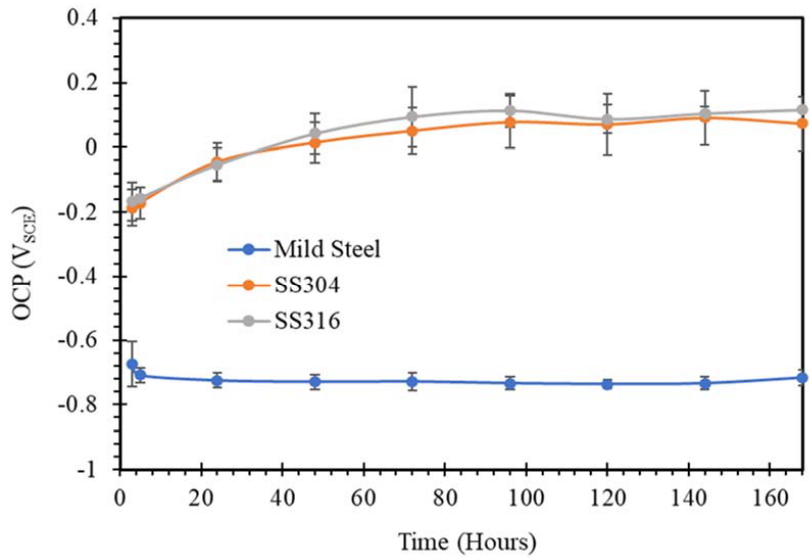
Figure 1. OCP vs. time plots of mild steel, SS304 and SS316 in SW solution.